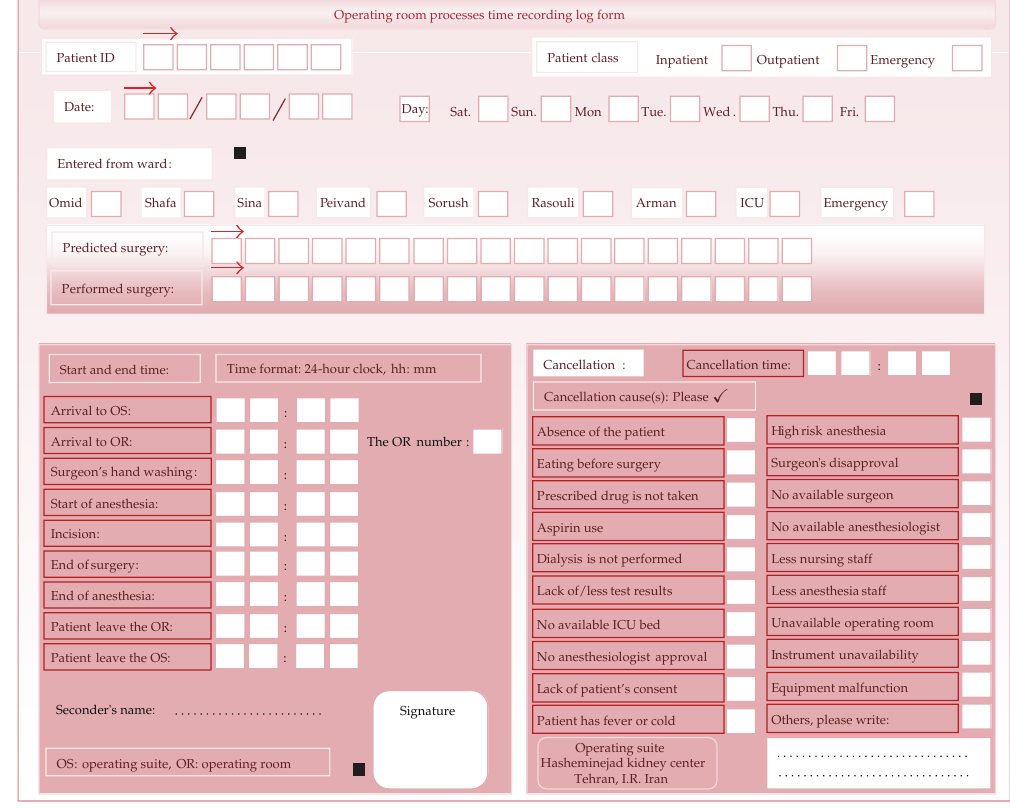
Figure 5: Operating room processes time recording log